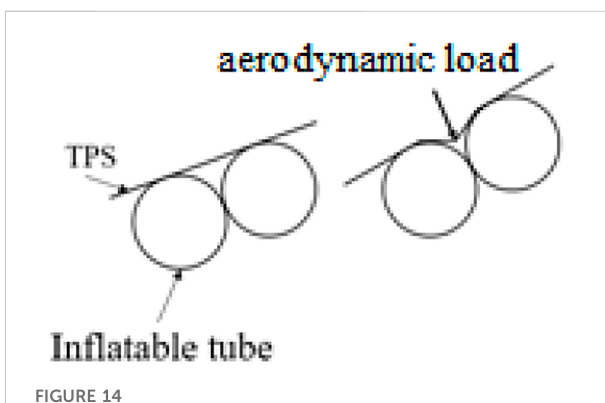
FIGURE 14 Schematic diagram of local collapse of TPS layer caused by aerodynamic